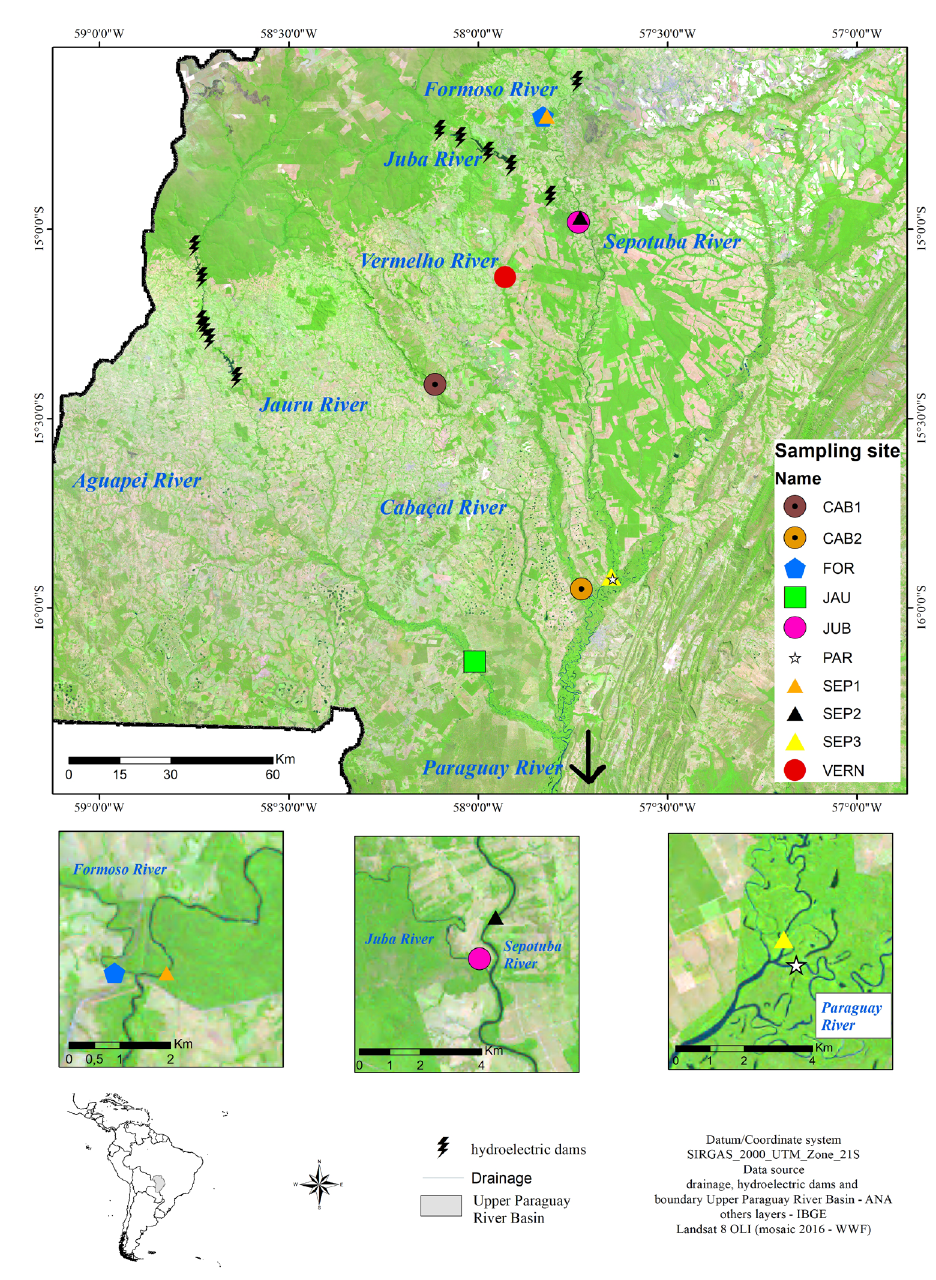
FIGURE 1 | Study area in the Brazilian upper Paraguay River basin in the Brazilian state of Mato Grosso, sampled during the 2017/18 and 2018/2019 breeding seasons. CAB1 = Cabaçal River site 1; CAB2 = Cabaçal River site 2; FOR = Formoso River; JAU = Jauru River; JUB = Juba River; PAR = Paraguay River; SEP1 = Sepotuba River site 1; SEP2 = Sepotuba River site 2; SEP3 = Sepotuba River site 3; VERN = Vermelho River. The overlap of the FOR/SEP1, JUB/SEP2 and SEP3/PAR sites corresponds to the proximity of the collected water